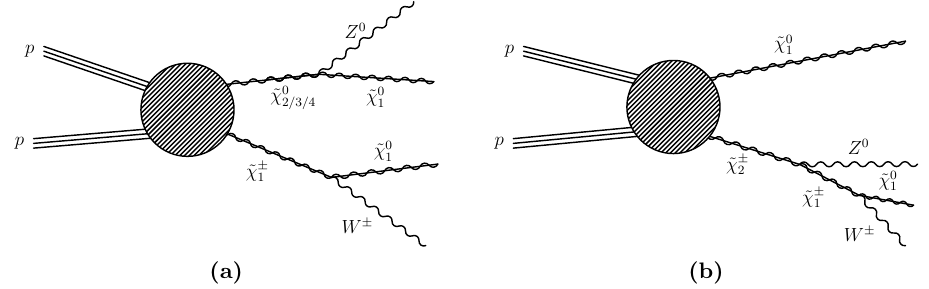
Figure 1. The two signal topologies, (a) S 1 and (b) S 2 , that can contribute to the 3 ‘ + =E